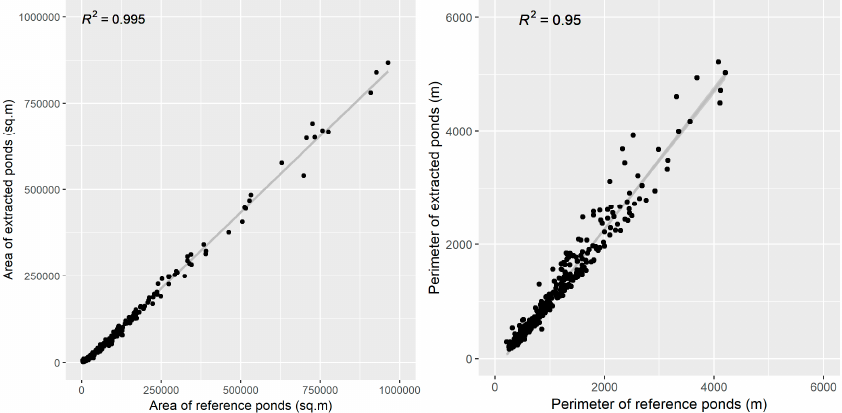
Figure 7. Area and perimeter of automatically extracted ponds compared to manually digitized reference ponds.